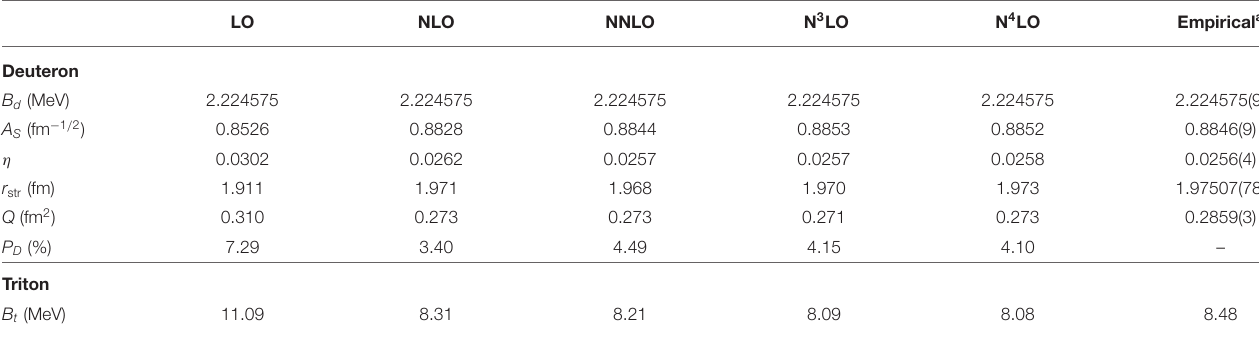
500 MeV in all cases). =